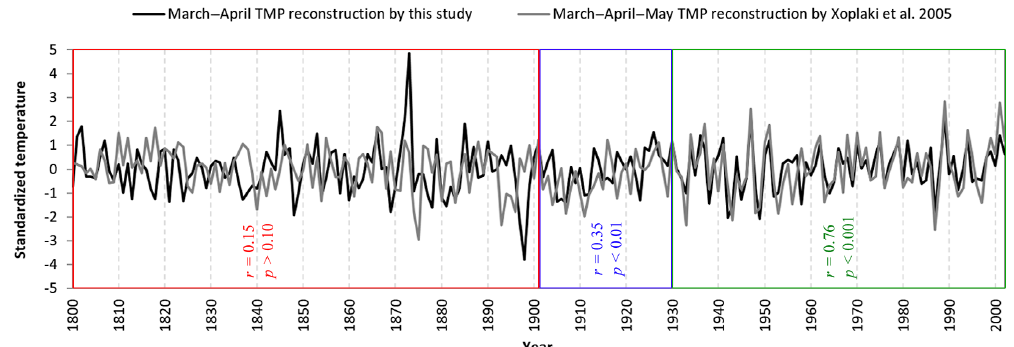
Figure 9. Comparison of March–April temperature reconstruction (gray) with the mean of corresponding grid points from European spring (March to May) temperature reconstruction (Xoplaki et al., 2005; black) over the study area (36–42 ◦ N, 26–38 ◦ E). The indicated correlation coefficients are calculated for instrumental period (also calibration period for this study; 1930–2002; r = 0.76, p <0.001); for the pre- instrumental period of Turkey, while instrumental data has sufficient quality for most parts of Europe (1901–1929; r = 0.35, p <0.10); and for pre-instrumental period (1800–1900; r = 0.13, p